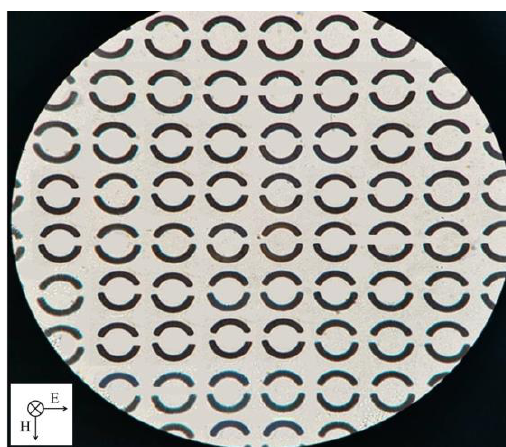
Figure 3. Optical microscope image of the sensor.